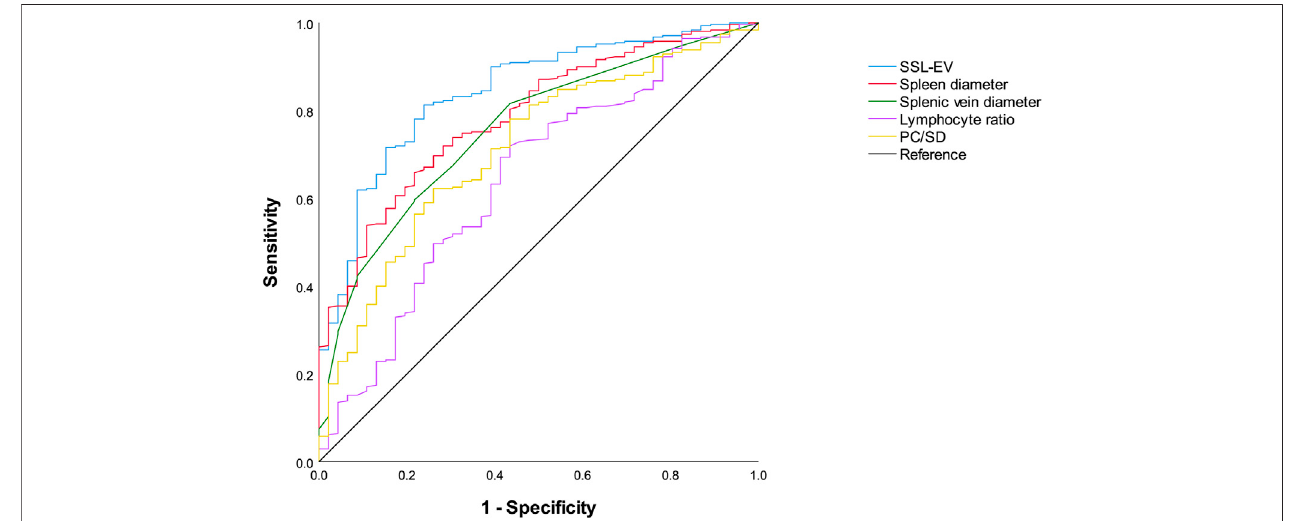
FIGURE 2 | Receiver operating characteristics curves of SSL-EV prediction model, spleen diameter, splenic vein diameter, lymphocyte ratio, and PC/SD for the diagnosis of EVs. SSL-EV prediction model, spleen diameter-splenic vein diameter-lymphocyte ratio-esophageal varices prediction model; PC/SD, platelet count to spleen diameter ratio.